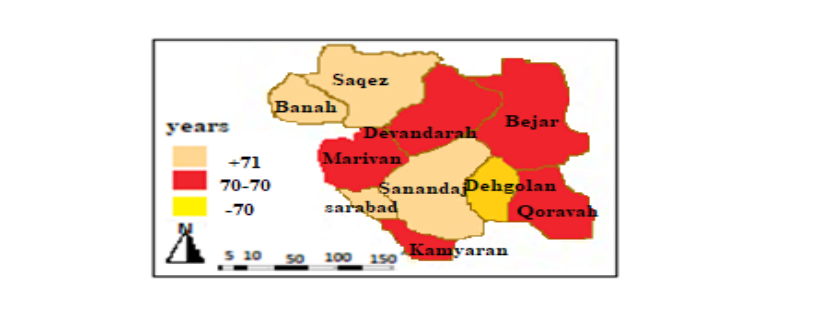
Bahrami R & Noori K. Life Expectancy in Rural Areas. J Adv Environ Health Res. 2021;